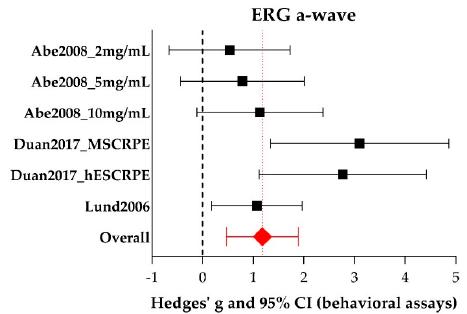
Figure 5. The meta-analysis of the e ff ect of RPE transplantation on the size of the ERG a-wave amplitude. For every experimental group, Hedges’ g (a measure for e ff ect size using smaller sample sizes, black solid squares) and its 95% confidence interval (CI) are graphically shown. The left side of the dashed black line (Hedges’ g = 0) favors the control group (untreated or sham-operated) and the right side favors the experimental group (RPE transplantation). RPE transplantation significantly increases the a-wave amplitude (Hedges’ g 1.181(0.471–1.892), red